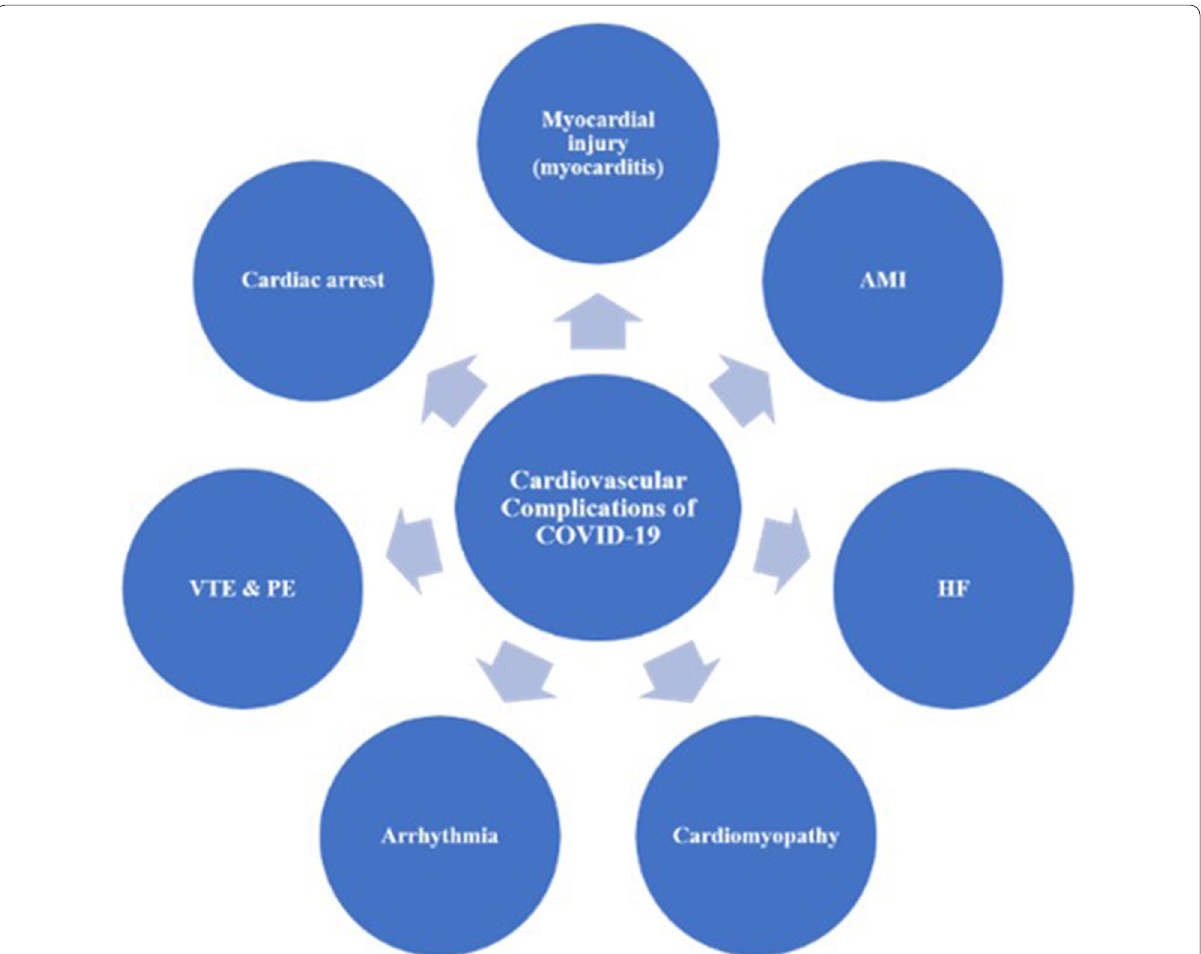
Fig. 2 Spectrum of cardiovascular complications in COVID-19. A wide spectrum of cardiovascular complications in COVID-19 is reported. AMI: acute myocardial infarction; HF: hear failure; VTE: venous thromboembolism; PE: pulmonary